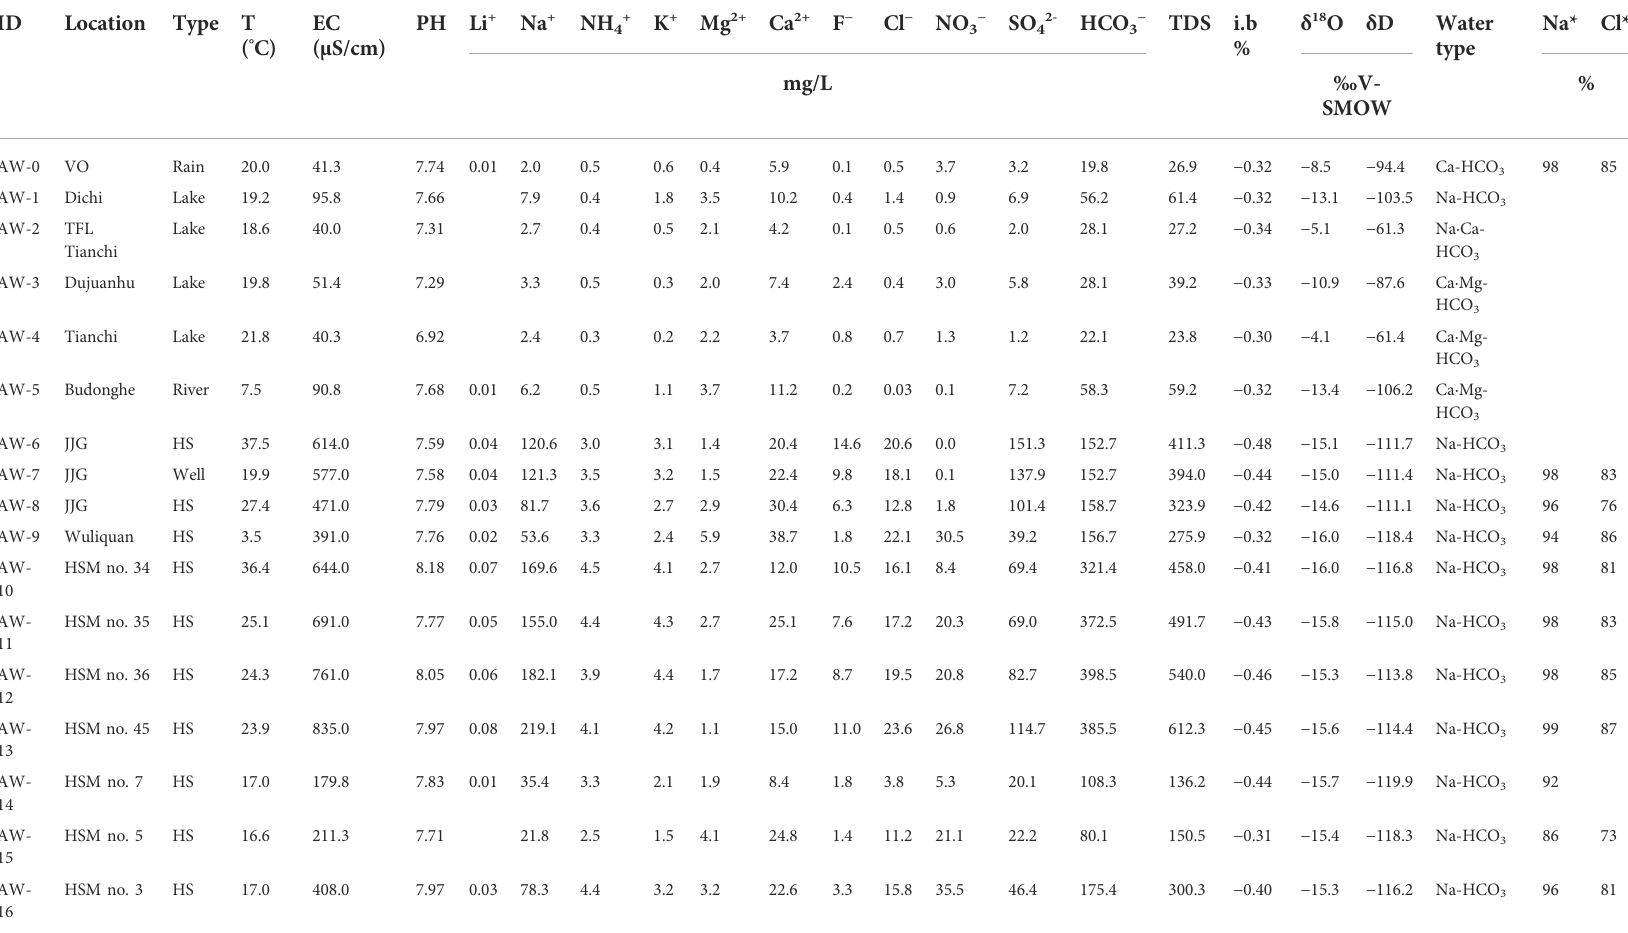
TABLE 1 Ion concentrations and isotopic ratios of the water samples from the Arxan volcanic region.